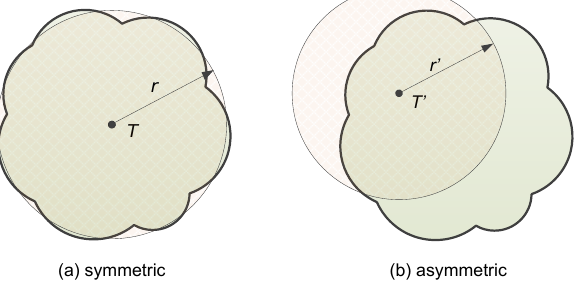
Figure 3: Area ratio calculation of (a) symmetric and (b) asymmetric tree crowns.